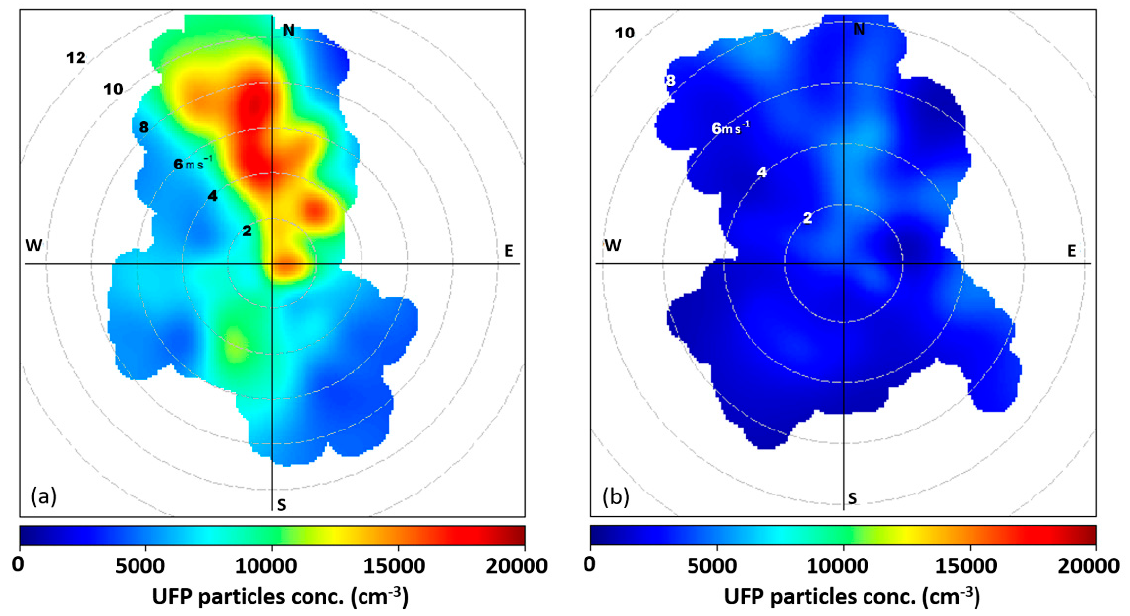
Figure 6. Pollution roses (bivariate polar plots) for UFP number concentrations during ( a ) the mirror period (2016–2019) and ( b ) lockdown phase. Wind speed and wind direction are represented by the concentric circles and the colored shape, respectively. The color bar is the average value of mean particle number concentration.